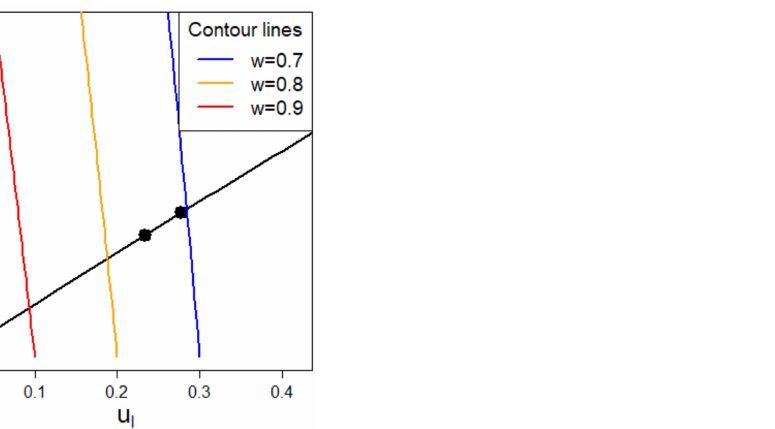
Figure 4. A segment of the regime graph is depicted in the area of the quick release regime. The solid line indicates all possible positions of any substance in the water borne wall paint scenario. The right and left point belong to a substance with vapor pressure of 10,000 Pa, a molecular weight of 80 g/mol, and initial concentration in the product of 20%. The right point represents the situation at the start of the evaporation process, but the situation moves down along the curve, while the substance evaporates until it reaches the left